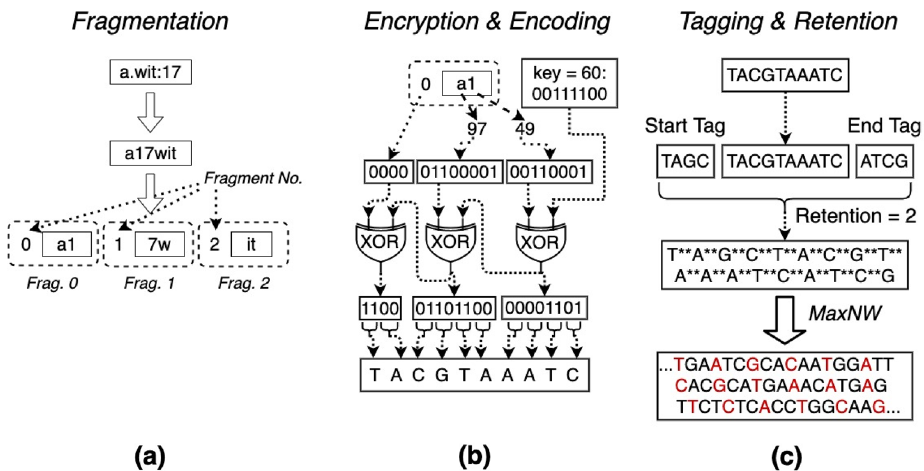
Figure 3. DNA Steganography, Workflow: ( a ) payload fragmentation, ( b ) fragment encryption and encoding, ( c ) tagging, retention and host injection. (The image is drawn using